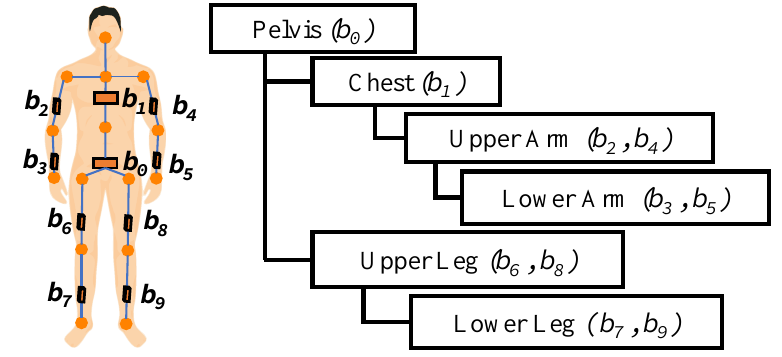
Figure 2. Three-dimensional (3D) avatar